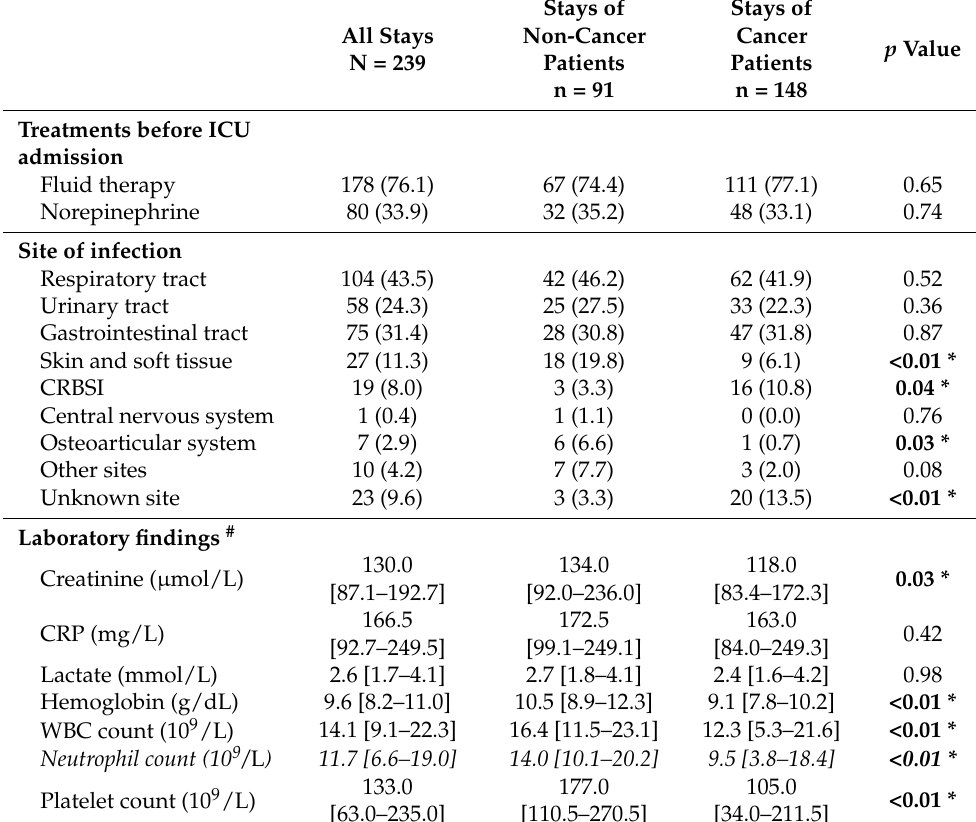
Table 2. Characteristics of the ICU stay for septic shock according to cancer